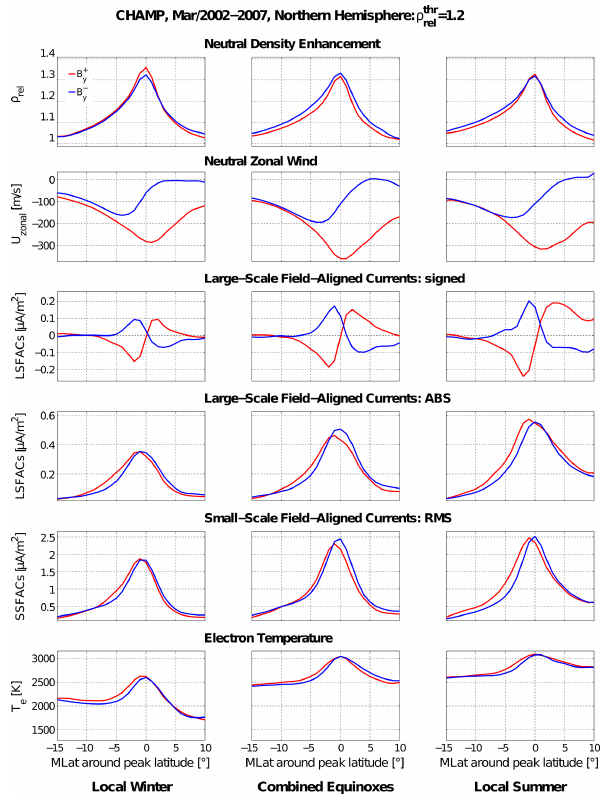
Fig. 1. The superposed epoch analysis curves of (from top to bot- tom) ρ rel , U zonal , LSFACs (signed and ABS), SSFACs (RMS), and T e for three local seasons: (from left to right) local winter, combined equinoxes, and local summer. The results are shown as functions of = 1 . 2. The data used cover IMF B + y (red) and B − y (blue) for ρ thr rel 5 years (March 2002–March 2007) of CHAMP observations in the Northern